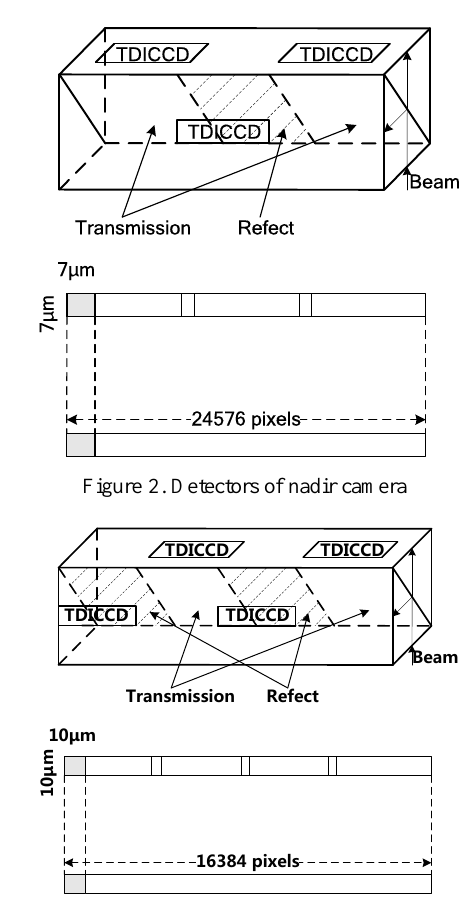
Figure 1. Structure of ZY-3 satellite three line array camera